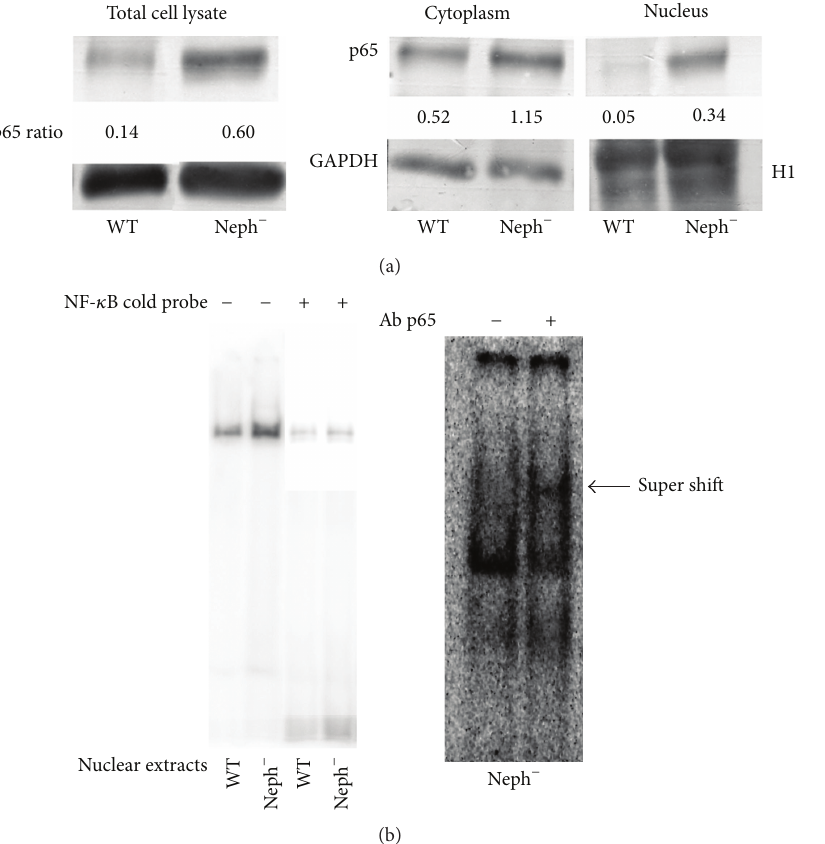
Figure 6: NF- 𝜅 B p65 expression, distribution, and EMSA for NF- 𝜅 B consensus in wild type and nephrin-mutated podocytes: (a) WT and Neph − podocytes were grown, fractionated, and processed for western blot as described in Section 2. The rabbit anti-p65 (sc-372) polyclonal antibody was purchased from Santa Cruz Biotechnologies (Santa Cruz, CA, USA). The sheep anti-histone H1 (H5110) polyclonal antibody was purchased from US Biological (Swampscott, MA, USA). To quantify the protein bands, we scanned the blots and performed a densitometry analysis, using the software NIH ImageJ v. 6.4 (freeware, NIH, MD, USA). (b) Nuclear extracts from WT and Neph − podocytes were prepared as indicated in Section 2. EMSA was performed using NF- 𝜅 B consensus [ 32 P]-labeled double-strand oligonucleotide. The sequence of the probe and the EMSA technique are described in Section 2. The anti-p65 antibody is the same as in part A of the present figure, but 10 times more concentrated (sc-372X) (Santa Cruz Biotechnology, Santa Cruz, CA, USA). The figure shows a typical experiment of at least three performed under the same